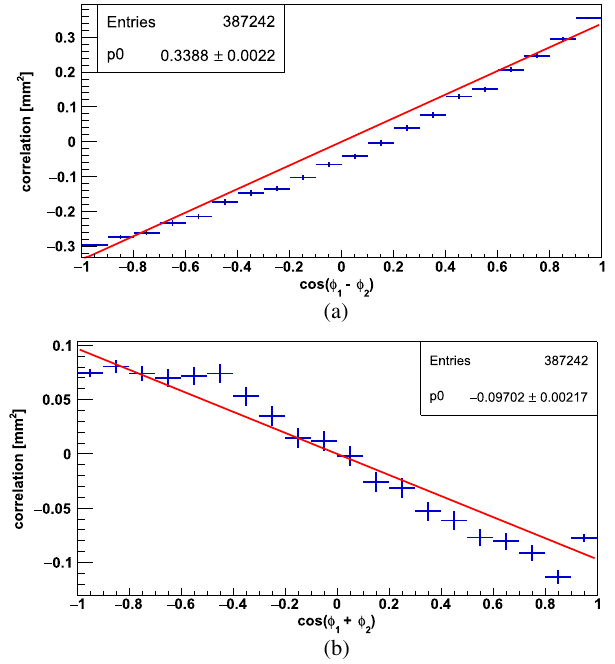
FIG. 10. IP correlation vs cos ð ϕ 1 − ϕ 2 Þ (a) and cos ð ϕ 1 þ ϕ 2 Þ (b). From the two line slopes and Eqs. (6) and (7), one gets for the transverse beam size σ x ¼ 660 μ m and σ y ¼ 492 μ m.